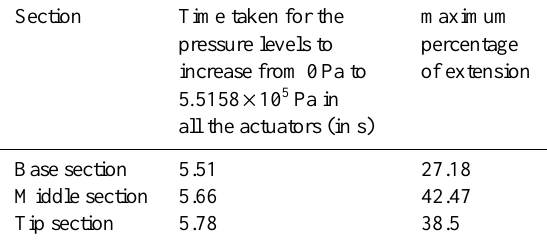
Table 3. Payload of Octarm.